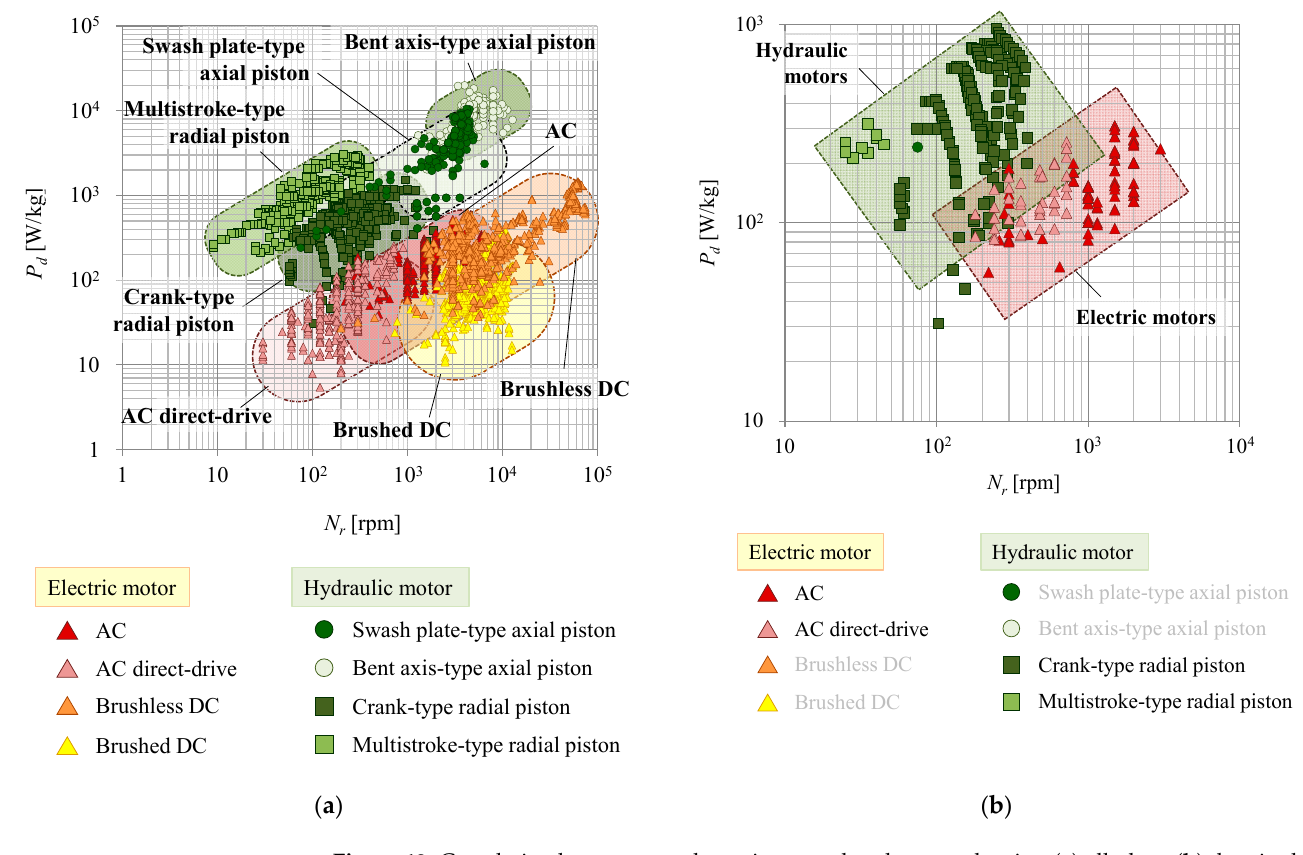
Figure 12. Correlation between rated rotating speed and power density: ( a ) all plots ; ( b ) data in the range surrounded by the red square in Figure 11.